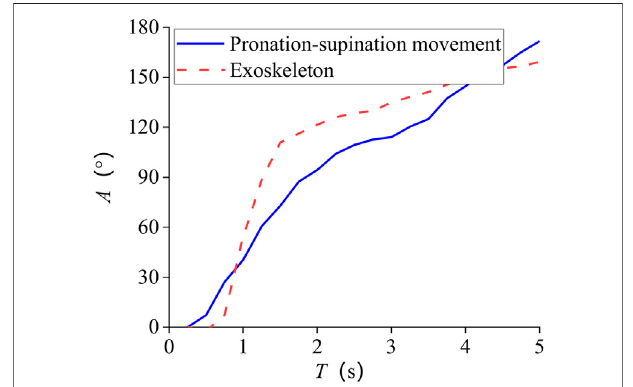
FIGURE 10 | Subject 2 tracking results of pronation – supination movement DOF.